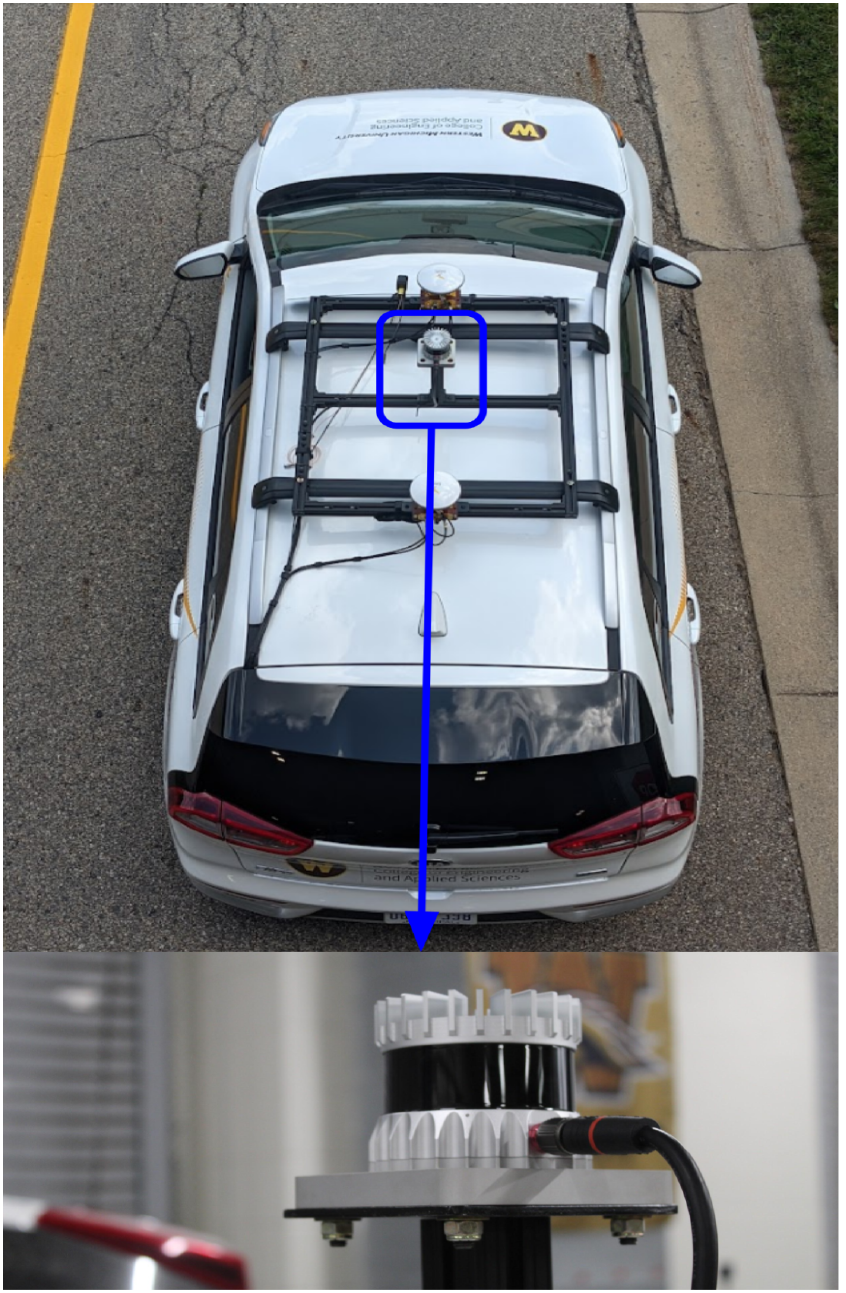
Figure 8. Ouster LiDAR OS1 mounted near the center of the vehicle with proper height for a surrounding view of the